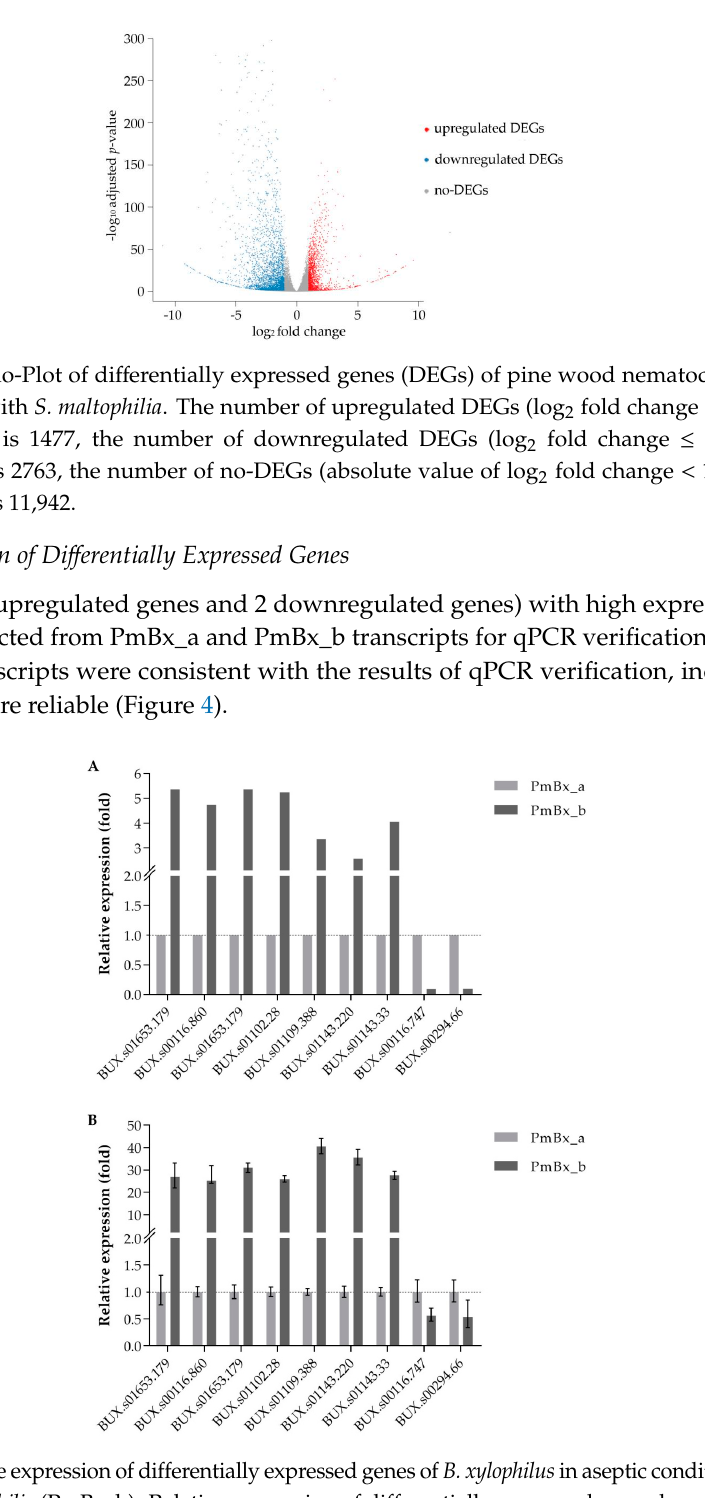
Table 3. New transcripts in the transcriptomes of aseptic B. xylophilus and B. xylophilus with S. maltophilia after inoculation.